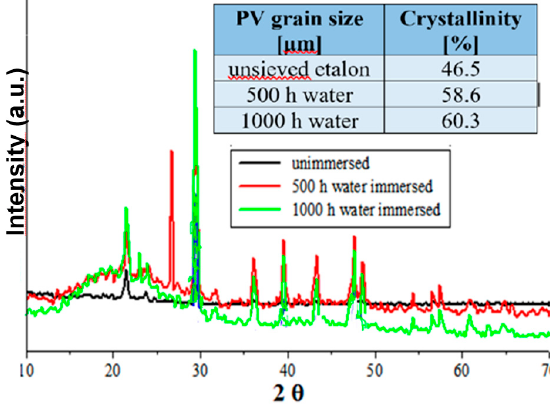
ff ractograms of the un-sieved 3% Si-PV hybrid Figure 6. XRD diffractograms of the un-sieved 3% Si-PV hybrid composite. Figure 6. XRD di